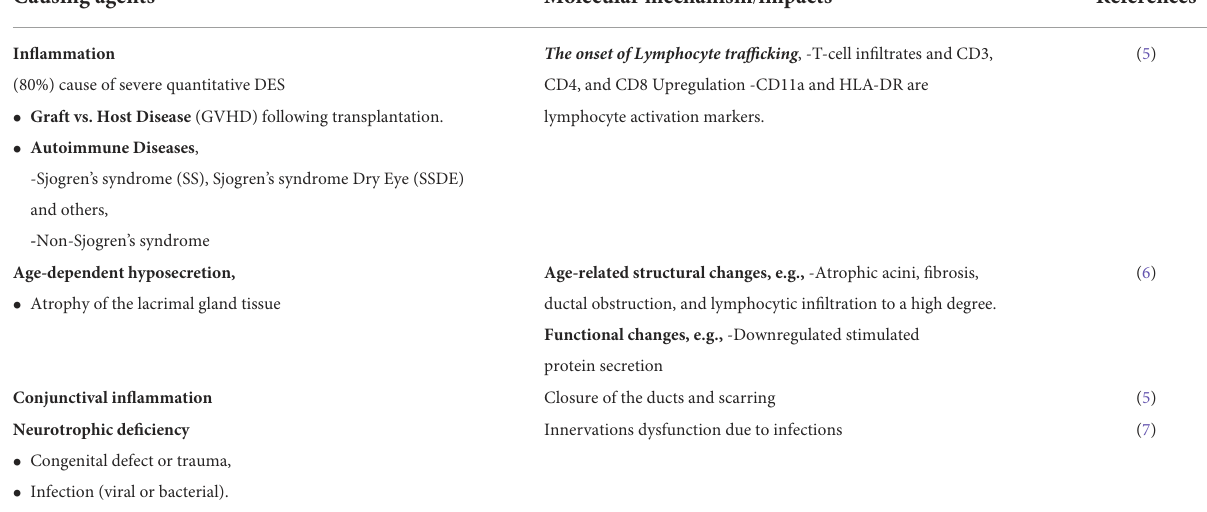
TABLE 1 Major dry eye causing